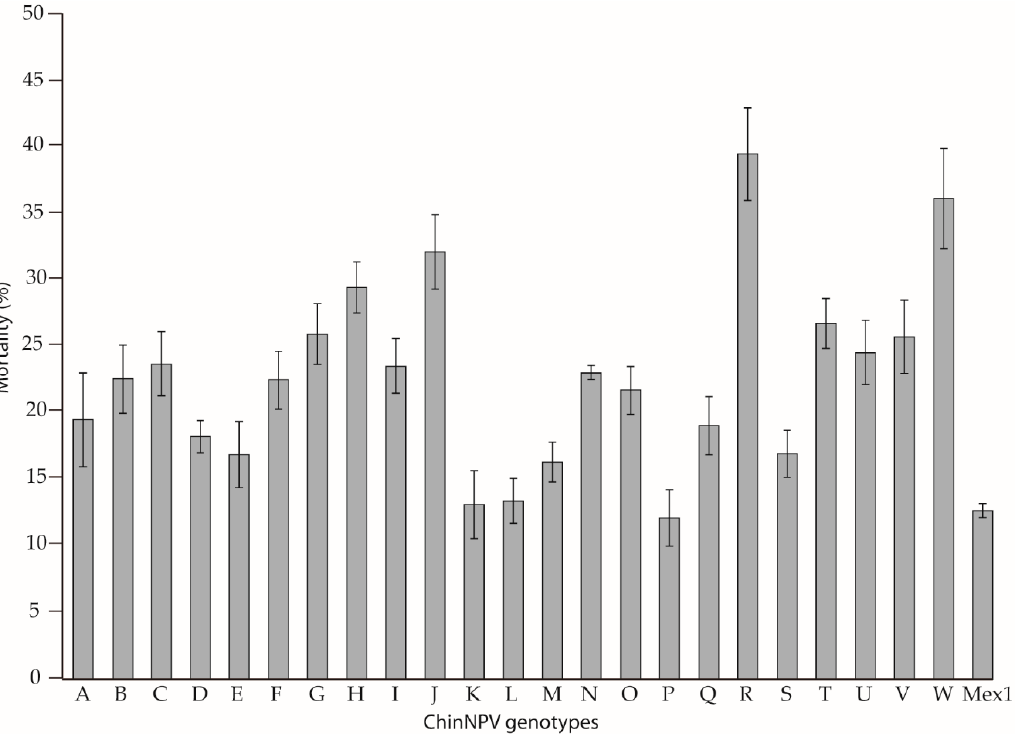
Figure 3. Percentage of mortality for each of the ChinNPV genotypic variants (A–W) and the ChinNPV-Mex1 mixture in C. includens second instars inoculated with 10 4 OBs/mL. Error bars indicate the standard error.